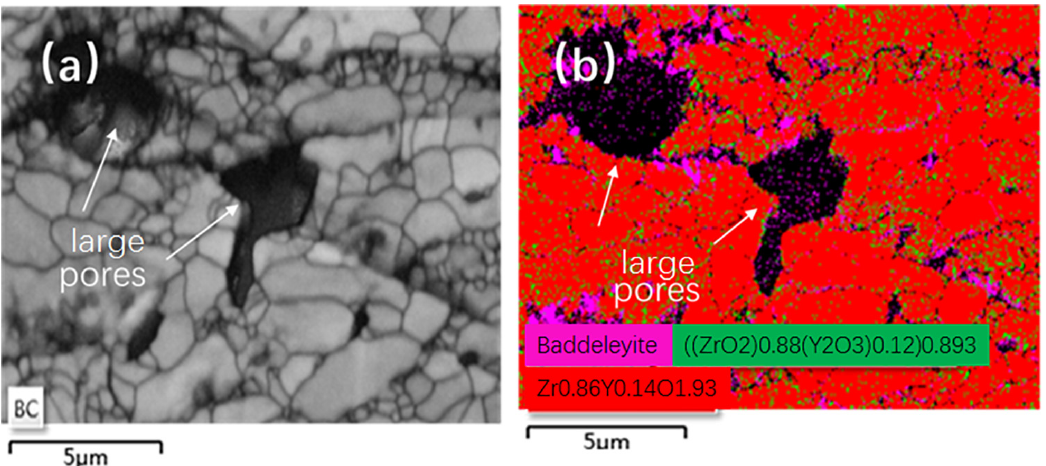
Figure 2. EBSD mappings of cross sections ( a ) grain boundary and ( b ) the phases distribution.